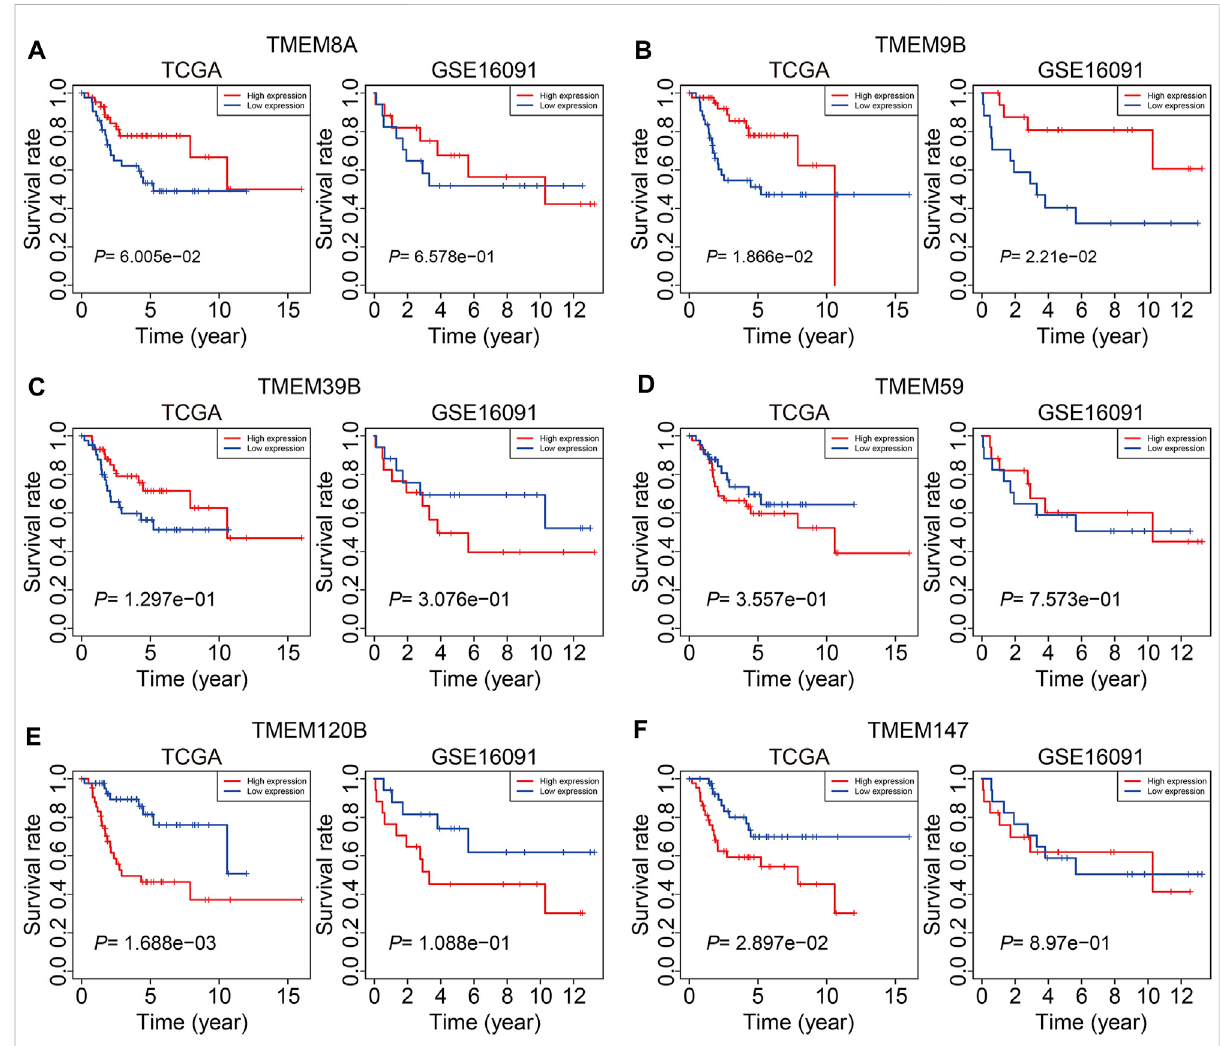
FIGURE 11 Kaplan – Meier survival curve analysis of TMEM8A (A) , TMEM9B (B) , TMEM39B (C) , TMEM59 (D) , TMEM120B (E) , and TMEM147 (F) in the TCGA and GSE16091